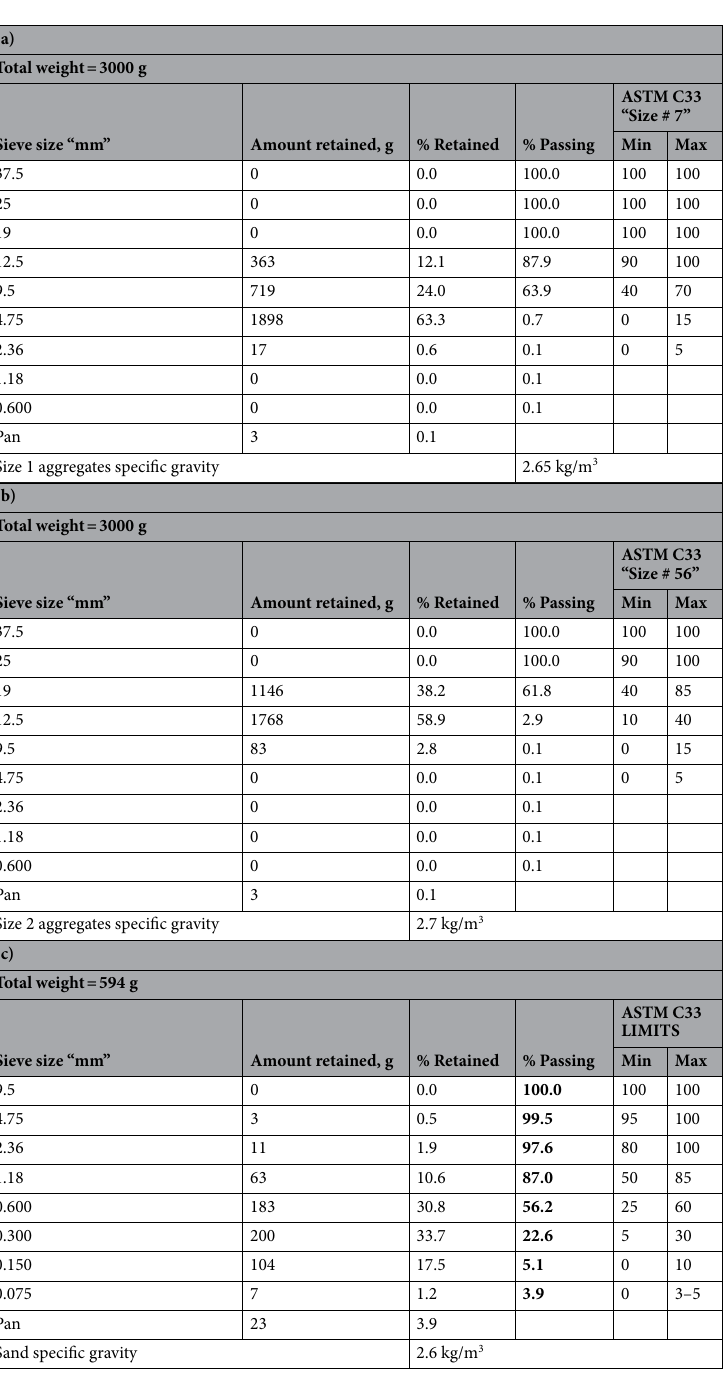
Table 8. (a) Sieve analysis of coarse aggregate (Size 1), (b) Sieve analysis of coarse aggregate (Size 2), and (c) Sieve analysis of fine aggregate (Sand). Significant values are in